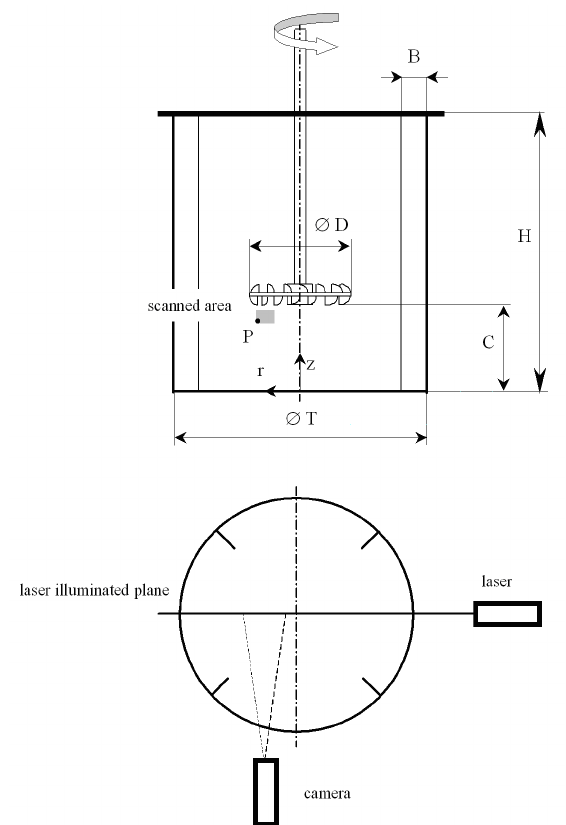
Fig. 1. Scheme of the experimental apparatus and the investigated